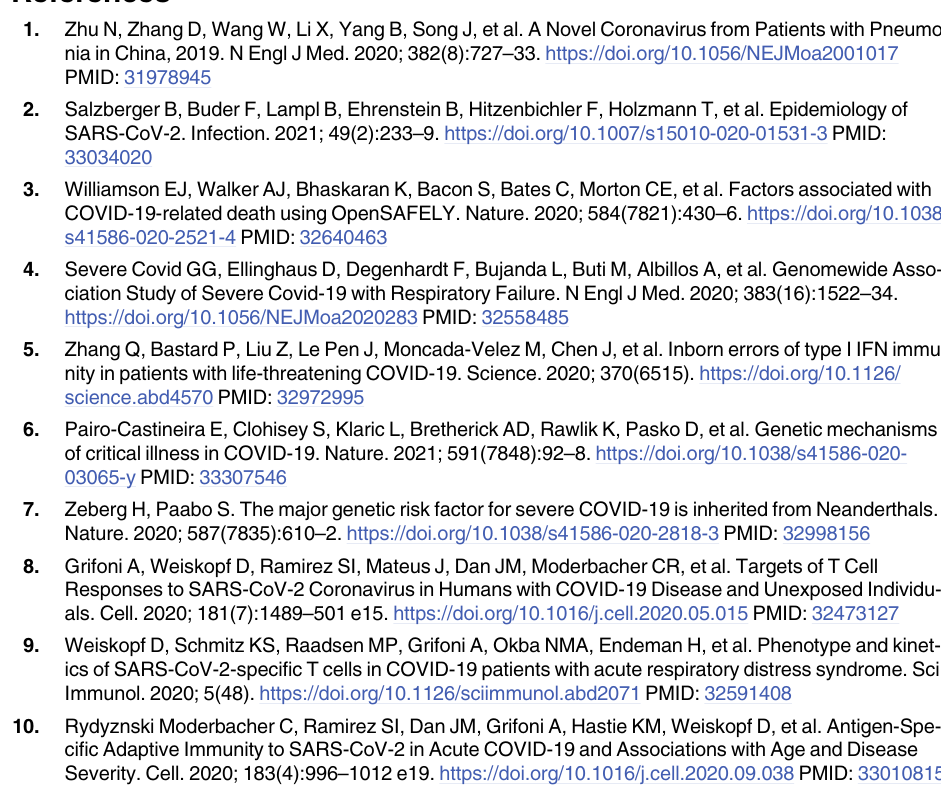
S5 Table. Antibody